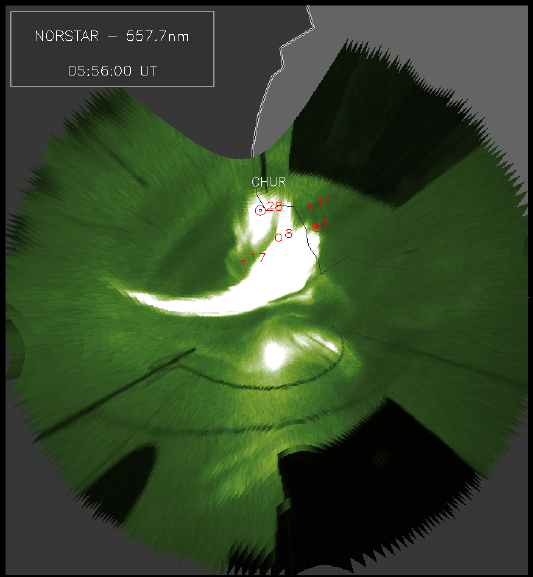
Figure 6. The mapped 557.7nm auroral emission observed in Gillam at 05:56UT on 7 March. The IPPs of five GPS satellites for the receiver in Churchill are shown as circles that are scaled proportionally to the 30s sDPR values between 2 and 10mms − 1